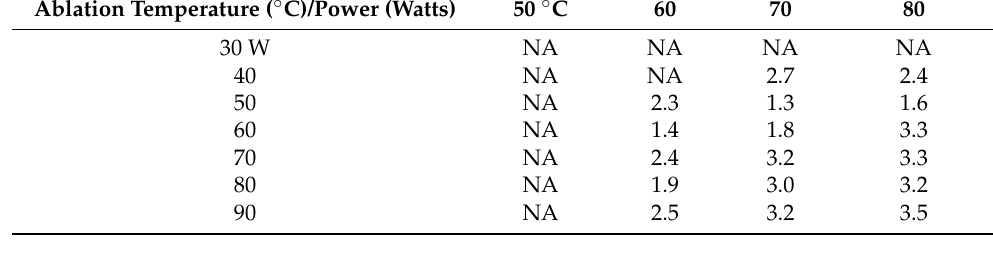
Figure 3. ( a ) Ablation lesion in chicken breast at 70 W, 70 °C, 60 s with a lesion diameter of ~3 mm, ( b ) Layfomm-40 disc with thermochromic paint coating showing the maximum size lesion that could be created at >90 W, >80 °C, 60 s with a lesion diameter of ~7 mm, and ( c ) Layfomm-40 square with thermochromic paint coating showing nine lesions at 70–80 W, 70–80 °C, 60 s with lesion di- ameters of ~3 mm. Table 1. Ablation lesion sizes (mm) on thermochromic Layfomm-40 discs using different ablation temperatures and power settings. The ablation duration was 60 s.